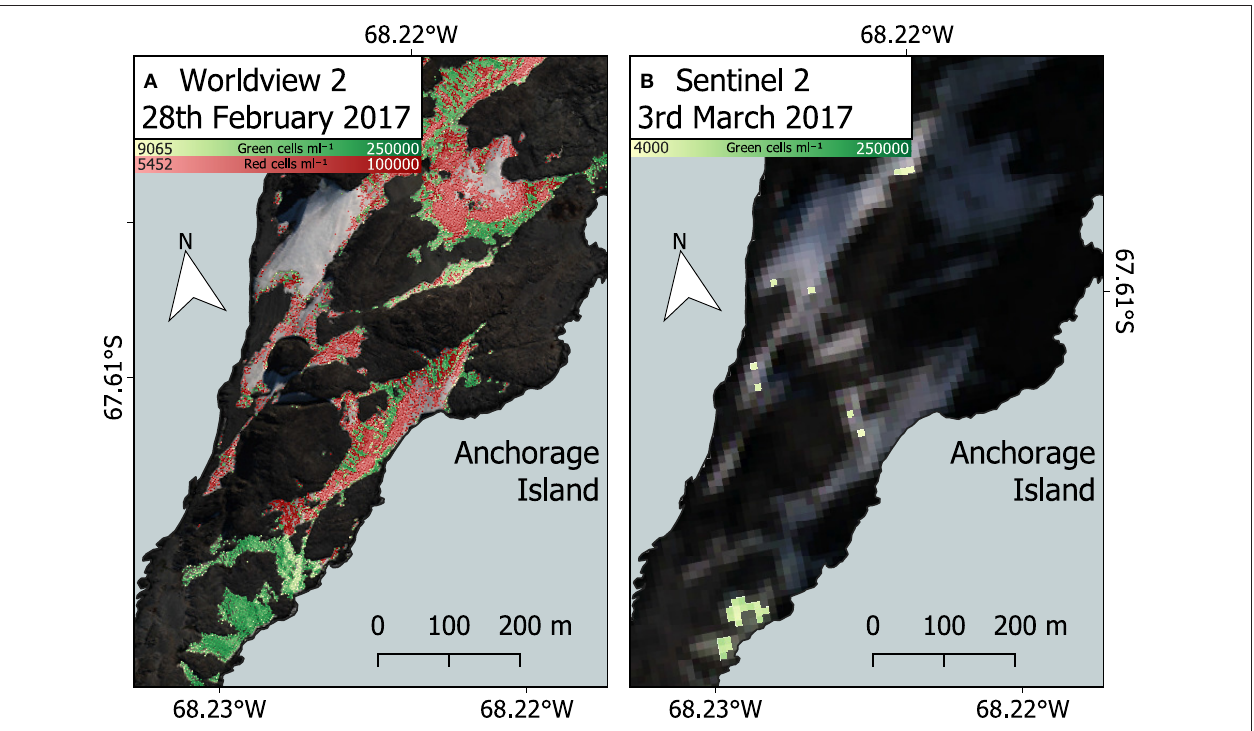
FIGURE 12 | Comparison between WorldView 2 and Sentinel 2. (A) WorldView 2 analysis of red and green snow algal distribution and cell density on February 28, 2017, Anchorage Island, Antarctica. (B) Green snow algal distribution and cell density based on a Sentinel 2 image from March 3, 2017, using methodology described by Gray et al. (2020). Note cloud shadow is partially obscuring the north east section in this image.